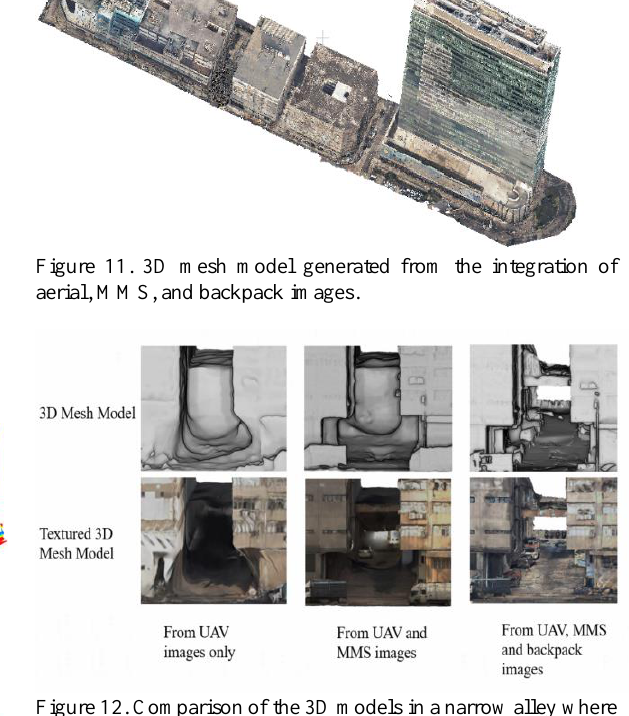
Figure 7. Unsigned CMD of an alley area calculated based on the model from UAV images only, UAV and MMS images, and UAV, MMS, and backpack images.